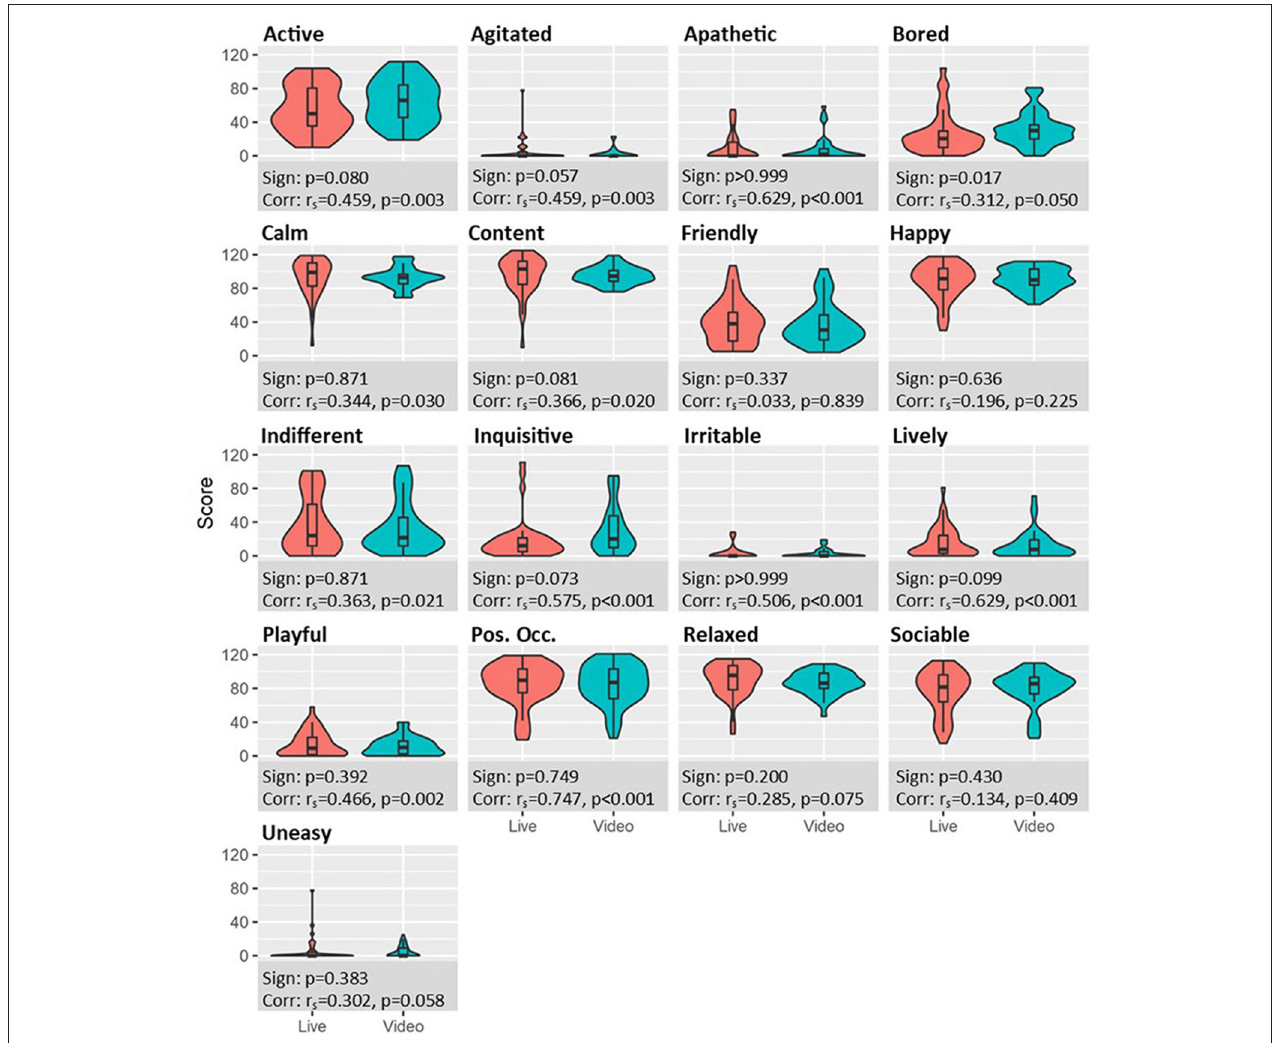
FIGURE 3 | Violin plots of scores for each term, split by live (left, red) and video (right, blue) assessments. Values in footers related to paired Sign tests and Spearman correlation for the respective term.